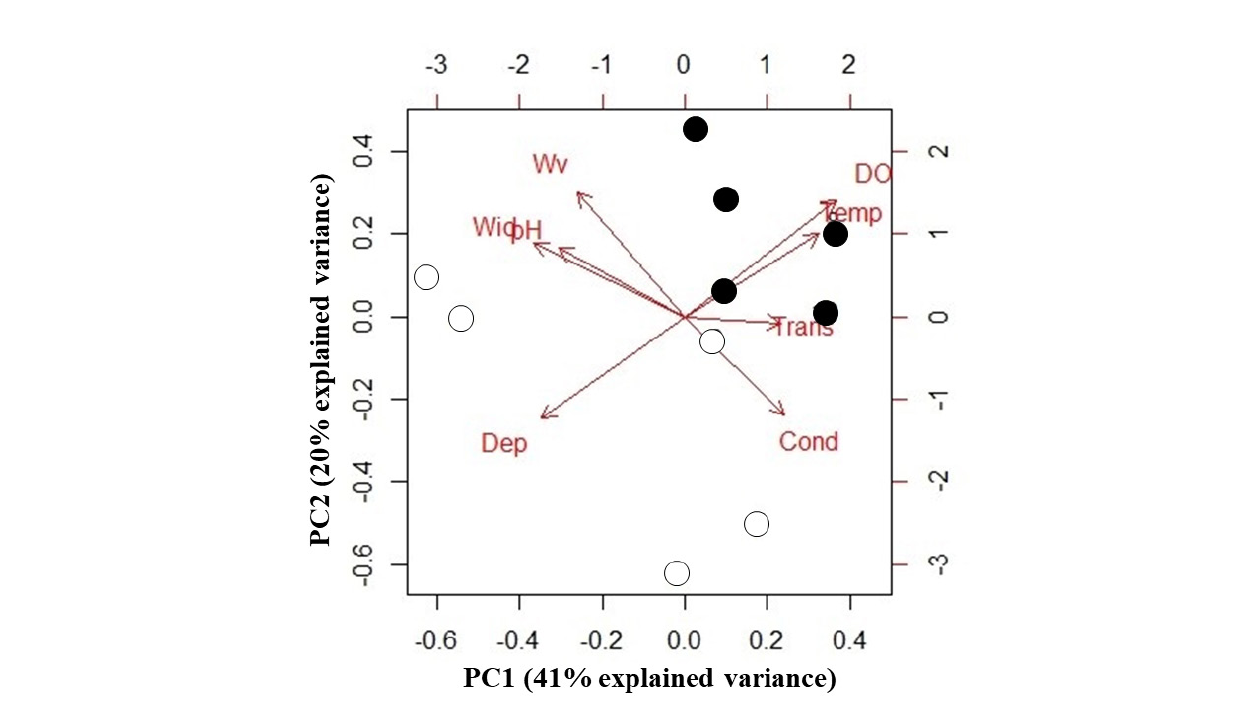
FIGURE 2 | Ordination of sampling sites in the Tarumã River basin studied during the high water (black circle) and low water (white circle) season, along the first two axes of the Principal Component Analysis